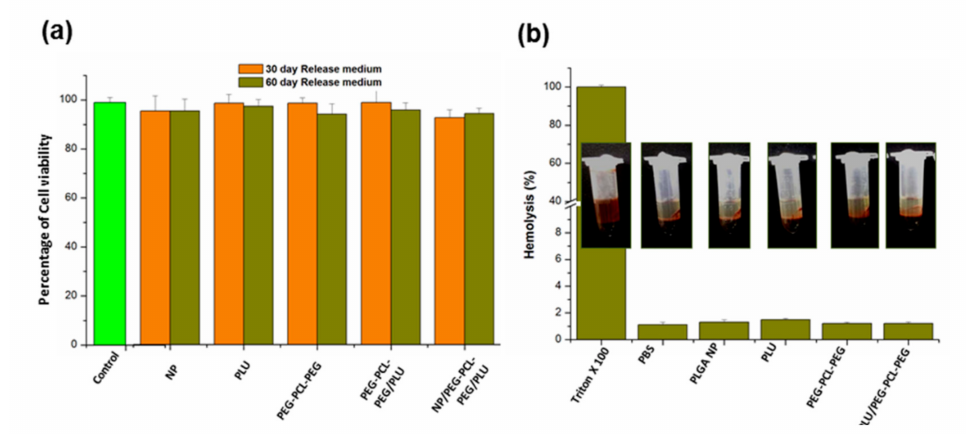
Figure 8. ( a ) Assessment of percentage cell viability after incubation with 30 days and 60 days release medium using MTT assay. ( b ) Analysis of haemolytic potential of different hydrogel systems and PLGA nanoparticles. Inset: Representative photograph showing no significant haemolysis in the hydrogel systems and PLGA nanoparticles in comparison to positive control (Triton ×